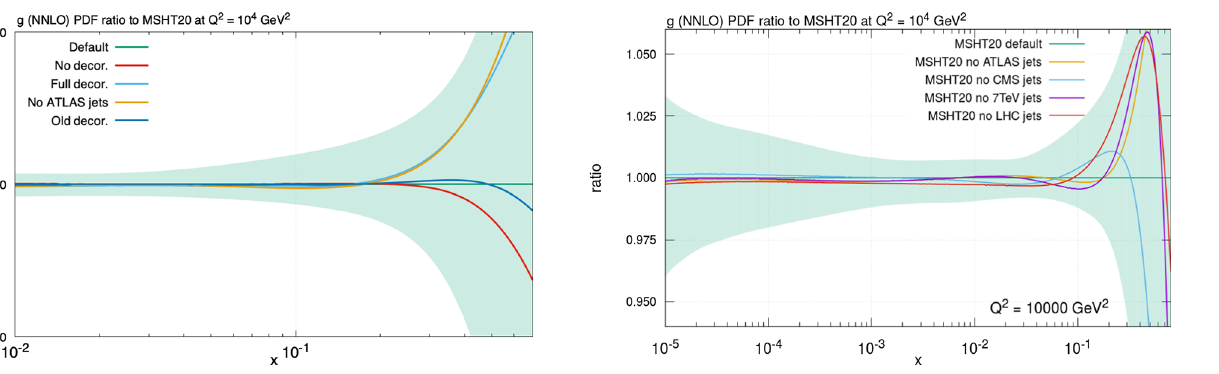
Fig. 11 Ratio of gluon PDFs to MSHT20 baseline, with α S free, at NNLO at Q 2 = 10 4 GeV 2 . The result of a fit to the ATLAS 7 TeV jet data, with the standard experimental correlated systematics errors (no decor.), a full decorrelation of all systematic errors across each rapidity bin (full decor.), and with the jet data removed from the fit, are shown